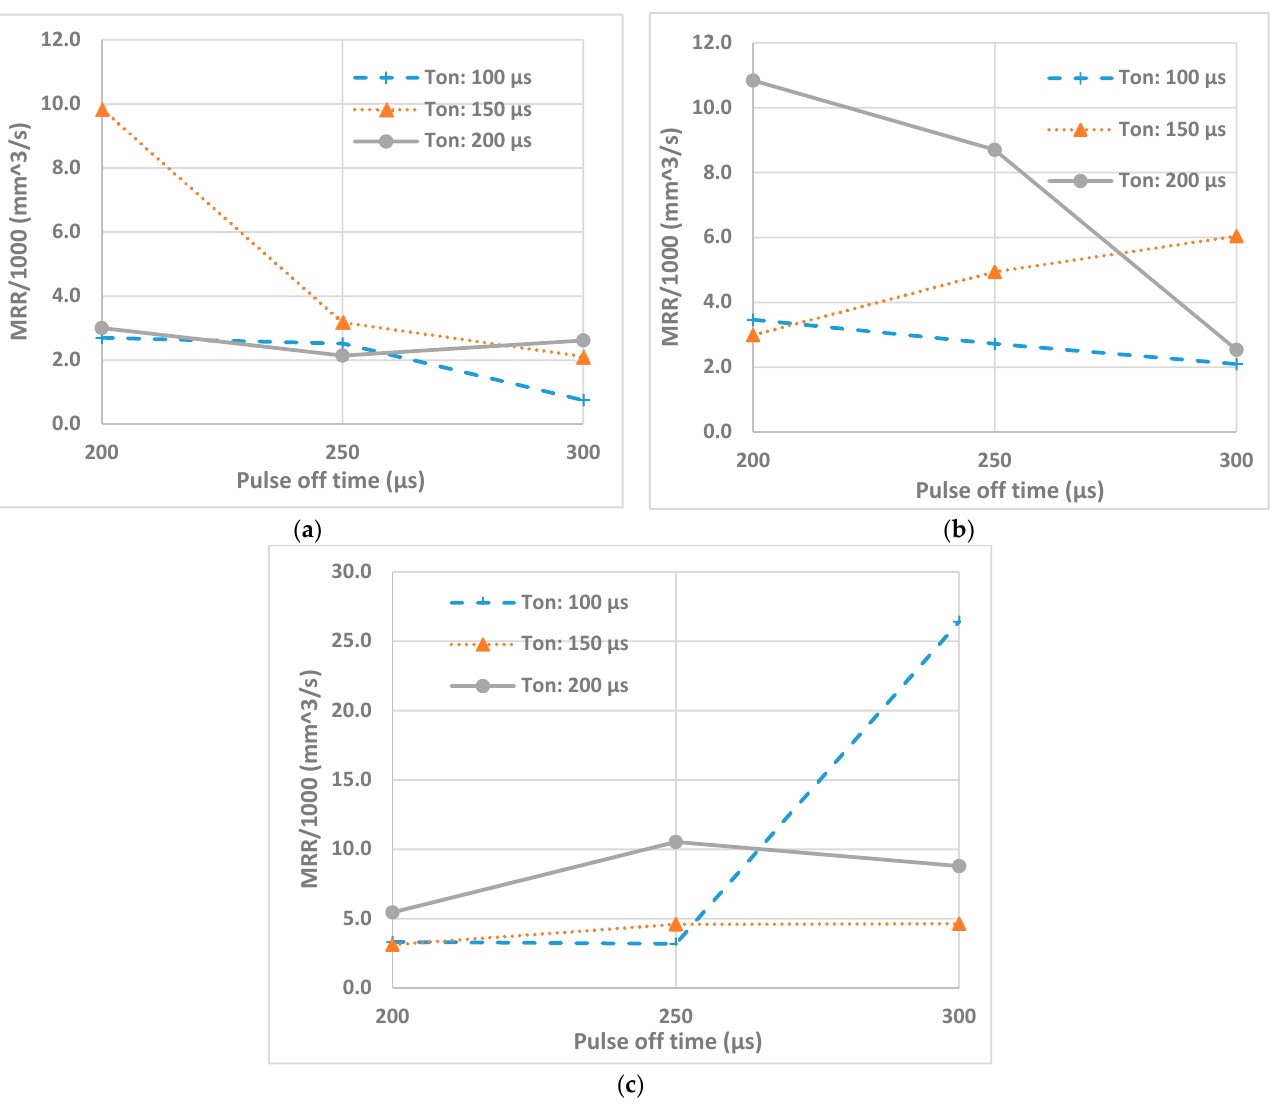
Figure 7. Effects of T on and T off on material removal rate (MRR) at Peak Current ( a ) 1 A, ( b ) 3 A, ( c ) 5 A.